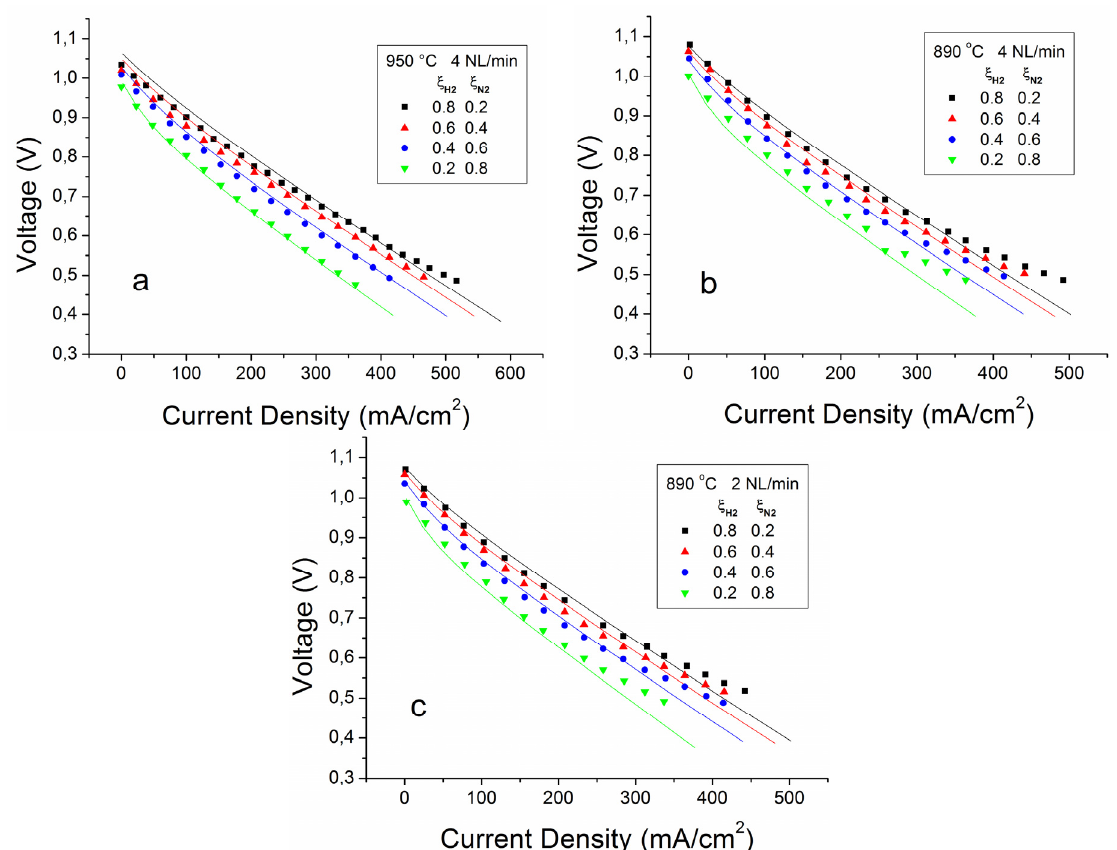
Figure 4. Validation of I ‐ V curves obtained with H 2 /N 2 fuel mixtures. Symbols: experimental. Lines: simulations. Captions indicate molar fractions of H 2 and N 2 in the dry fuel for cases ( a ) operating temperature 950 °C, fuel flow rate 4 NL/min ( b ) operating temperature 890°C, fuel flow rate 4 NL/min and ( c ) operating temperature 890°C, fuel flow rate 2 NL/min.